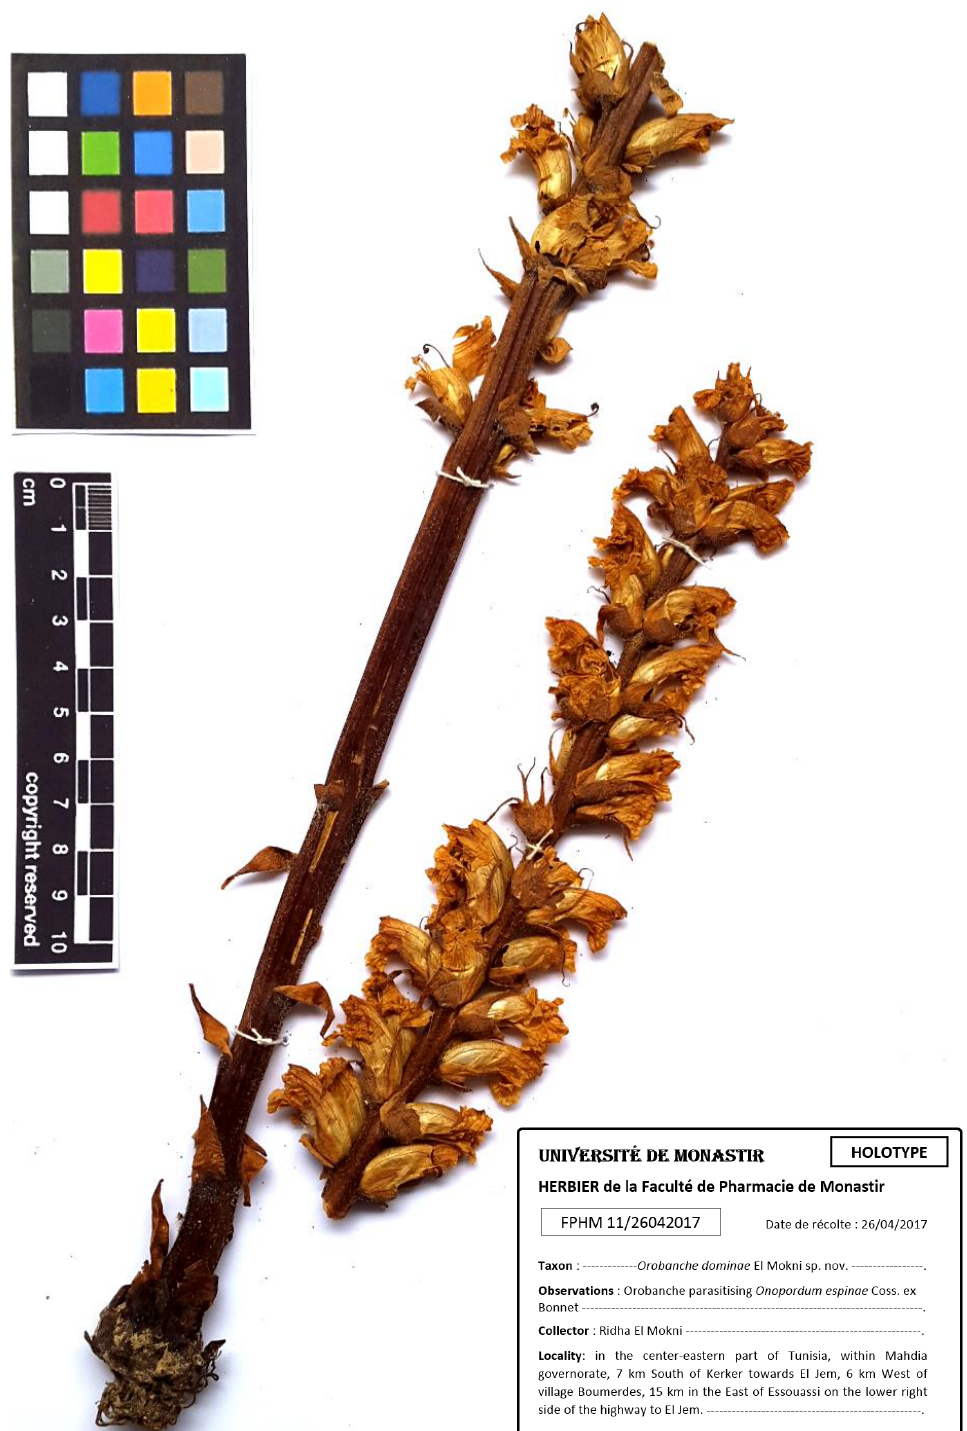
Figure 4. The holotype of Orobanche dominae El Mokni sp.